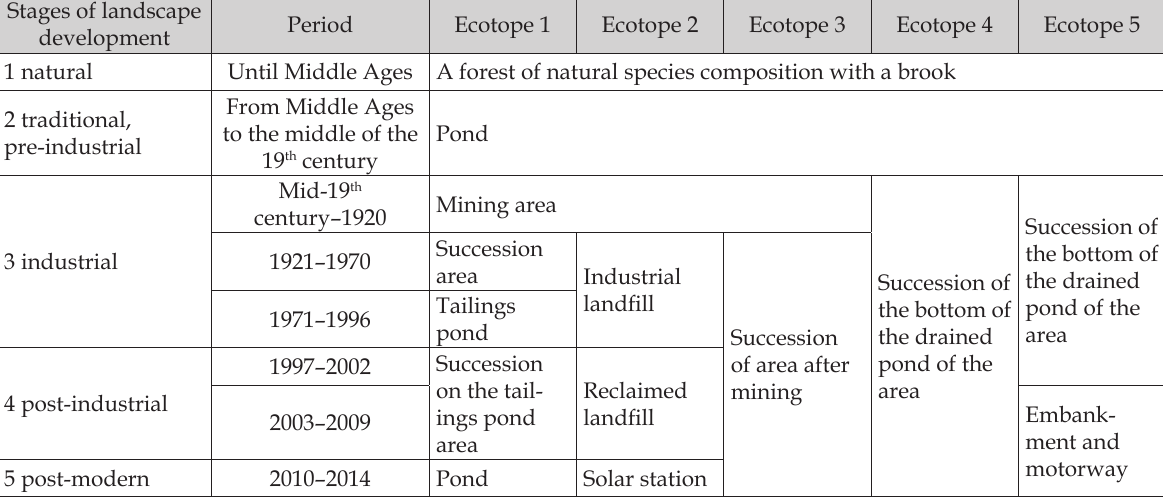
Table 1. Stages of ecotope development in the Sulkov